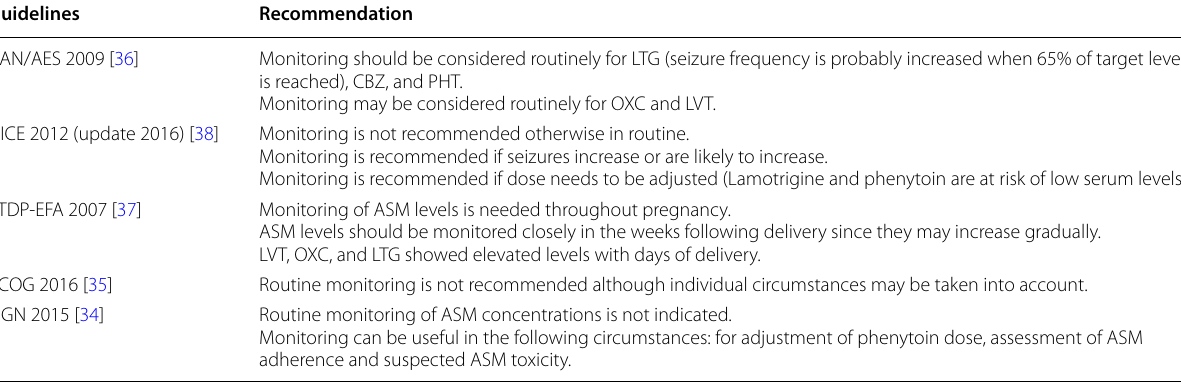
Abbreviations : ASM Antiseizure medication, AAN American Academy of Neurology, AES American Epilepsy Society, ETPD-EFA Epilepsy Therapy Development Project- Epilepsy Foundation of America, NICE National Institute for Health and Care Excellence, RCOG Royal College of Obstetricians and Gynaecologists, SIGN